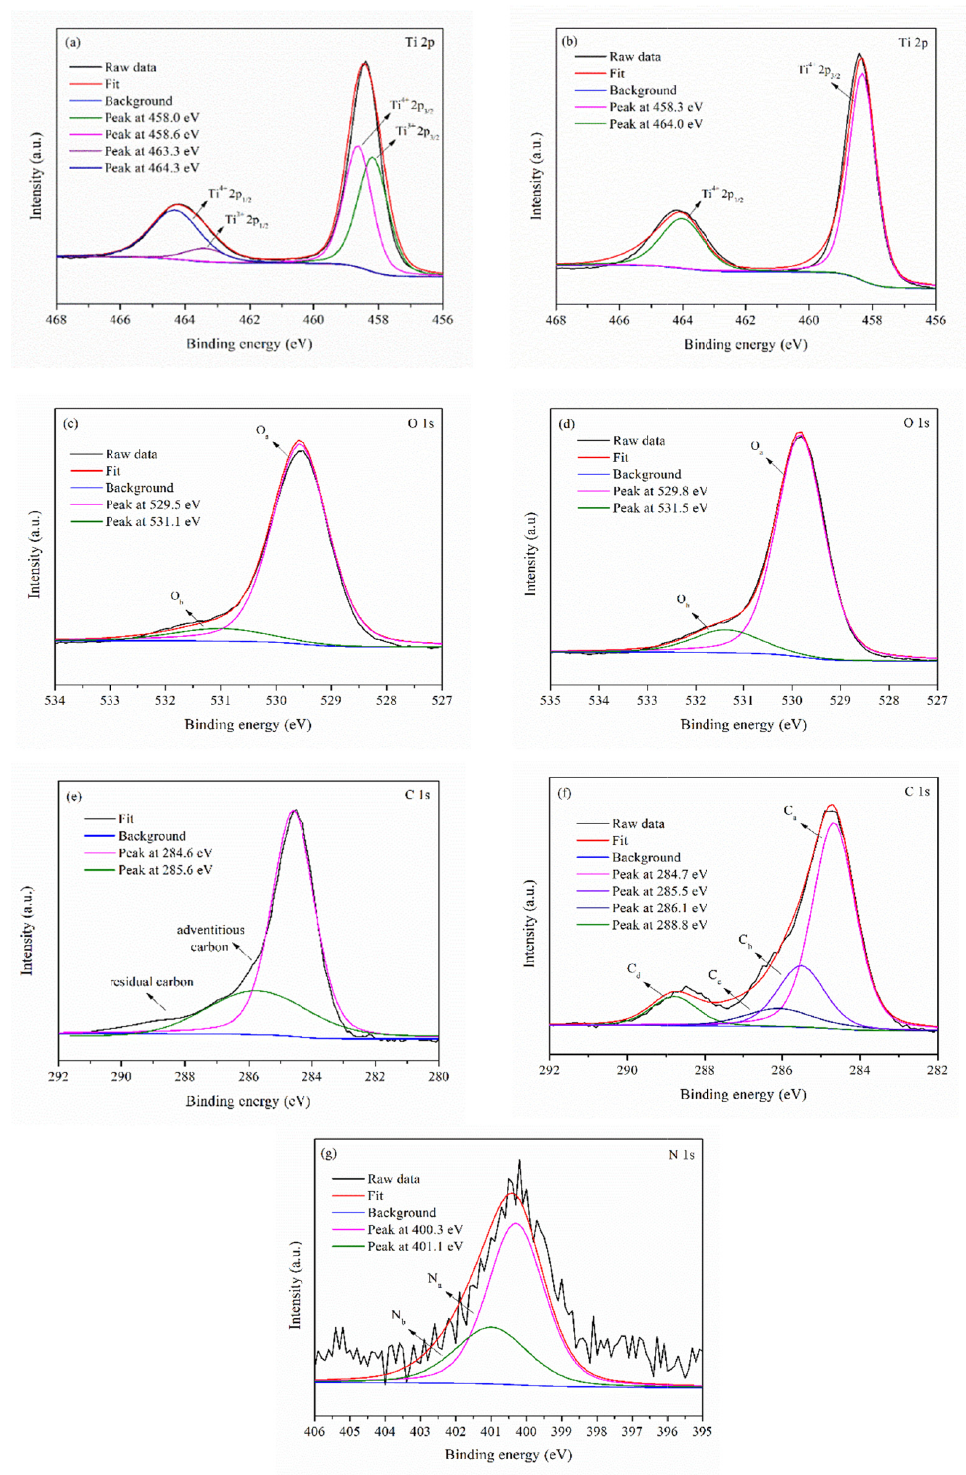
Figure 3. High-resolution XPS spectra of Ti 2p of synthesised ( a ) TiO 2 NPs and ( b ) N-GQDs/TiO 2 NCs, O 1s of synthesized ( c ) TiO 2 NPs and ( d ) N-GQDs/TiO 2 NCs, C 1s of synthesised ( e ) TiO 2 NPs and ( f ) N-GQDs/TiO 2 NCs, ( g ) N 1s of synthesized N-GQDs/TiO 2